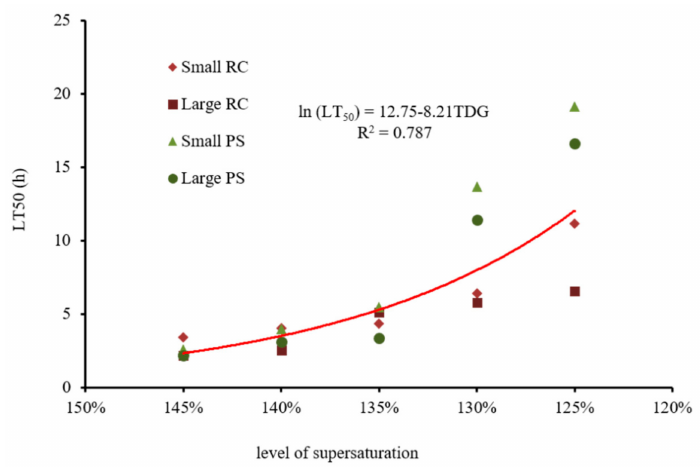
Figure 4. Changes in the median lethal time (LT 50 ) of experimental fish with di ff erent TDG supersaturation